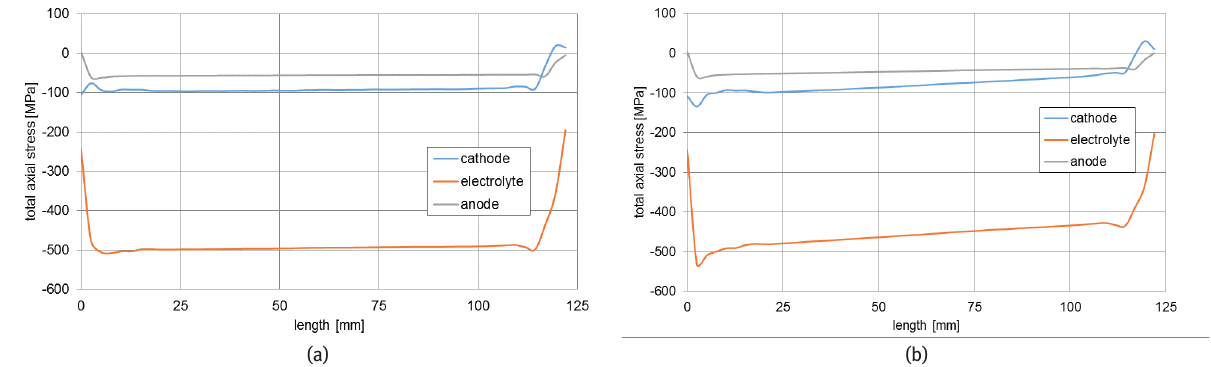
Figure 17: Distribution of total axial stress of the mSOFC stack with supporting structure along the horizontal centerlines of each layer: (a) cross-section I, (b) cross-section II.